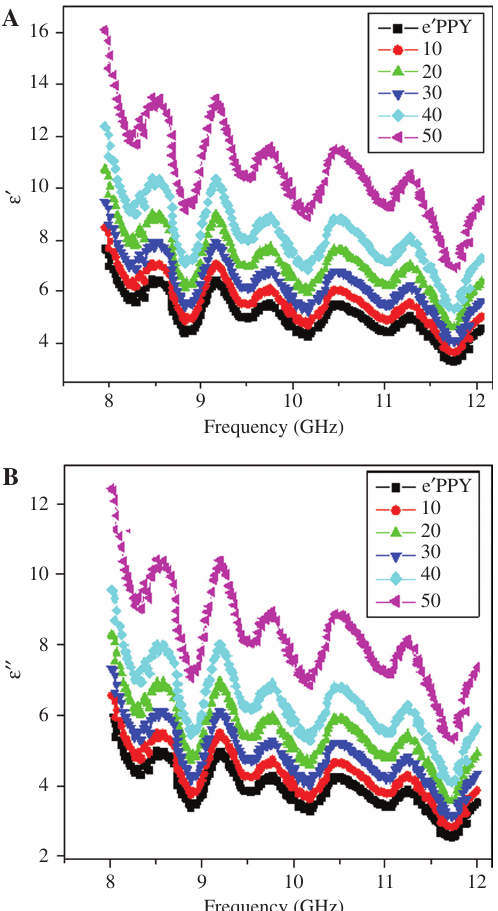
Figure 3 (A) Real part of permittivity as a function of applied frequency and (B) imaginary part of permittivity as a function of applied frequency.